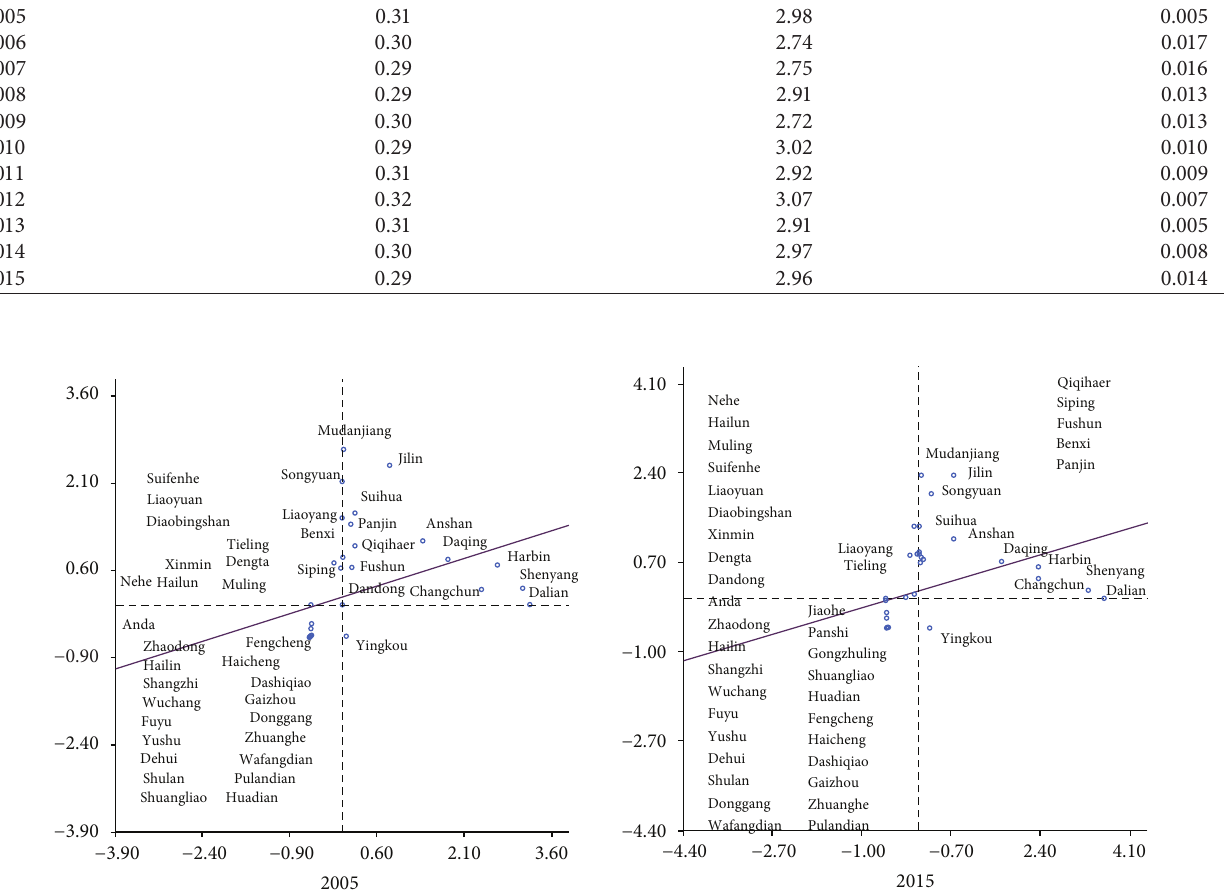
Figure 1: Moran Plot of GDP in Northeast China in year 2005 and